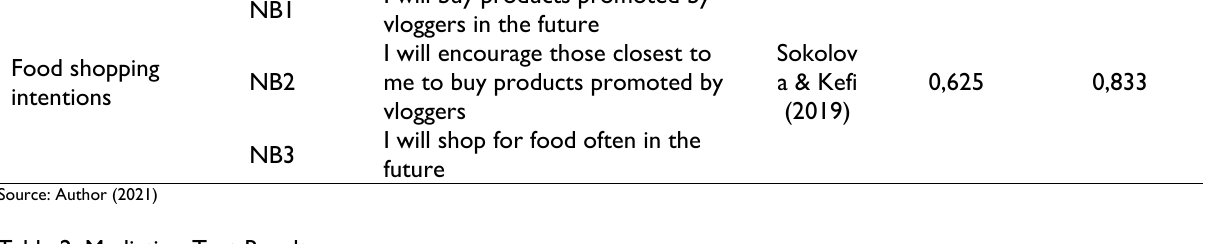
Table 2. Mediation Test Result